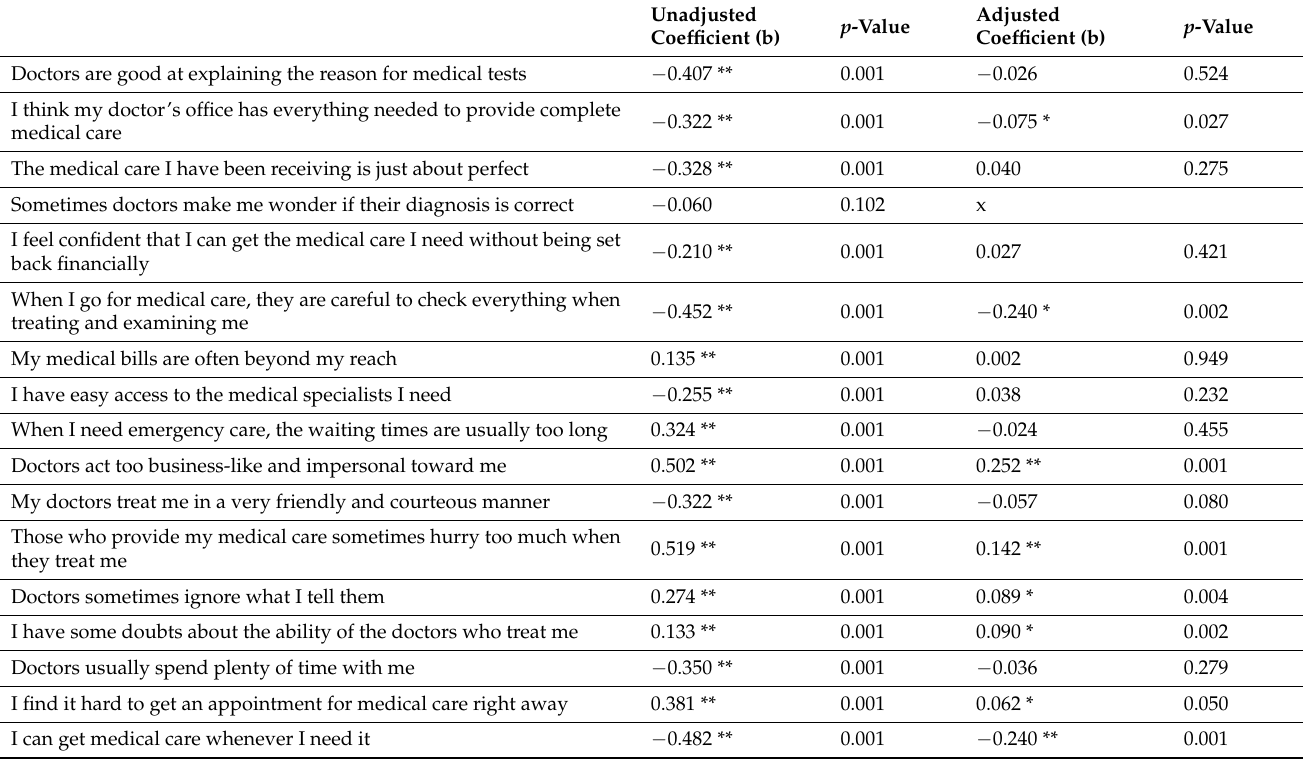
Table 3. Multiple regression model for overall satisfaction level with the medical care received and patient’s health care experiences.